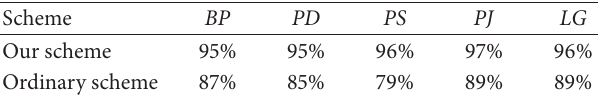
Table 3: Pattern recognition accuracy comparisons for our scheme and ordinary color moment-based scheme (RS).